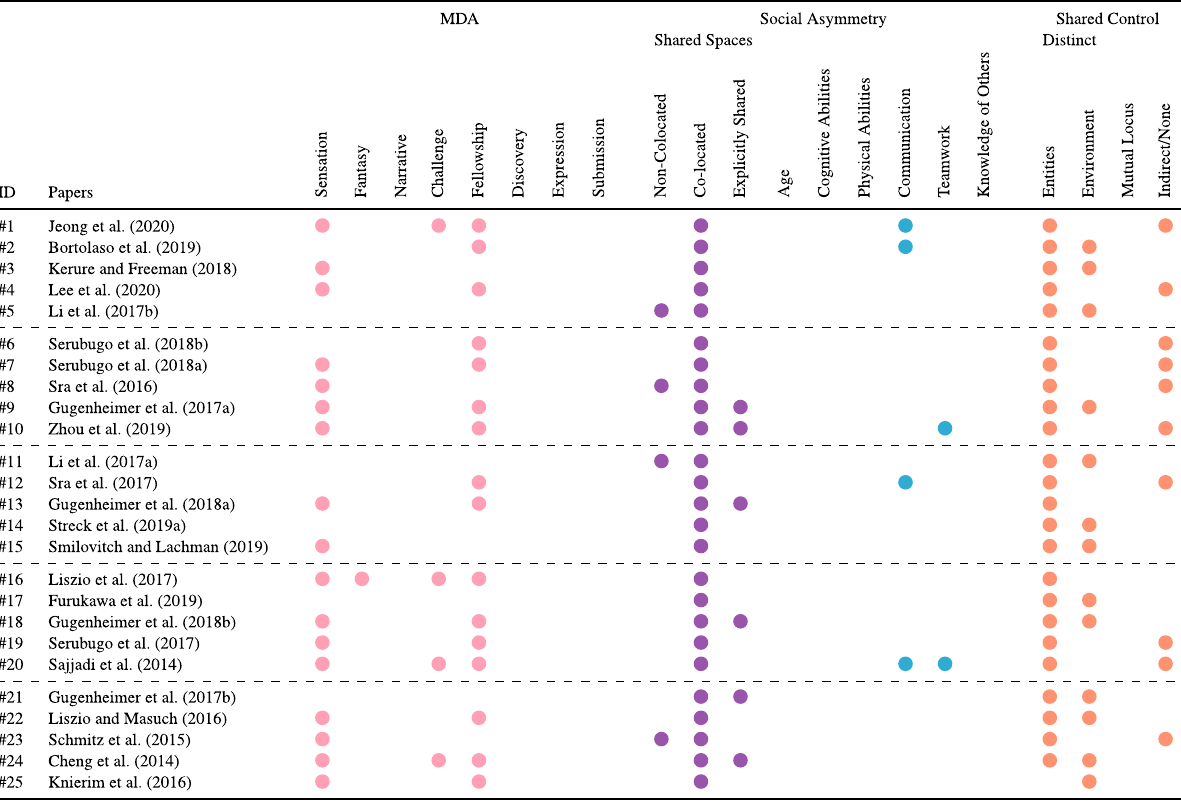
Frontiers in Virtual Reality |